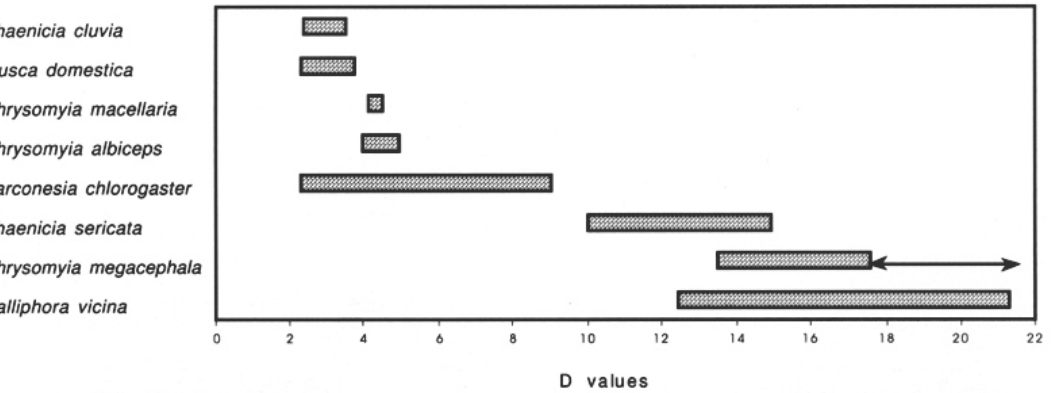
Figure 1. Taken from Maldonado and Centeno [47] showing the danger index (D) for flies collected and the arrow line showing the changes for Chrysomyia megacephala as considered now as hemisynanthropic (D = 19.43).